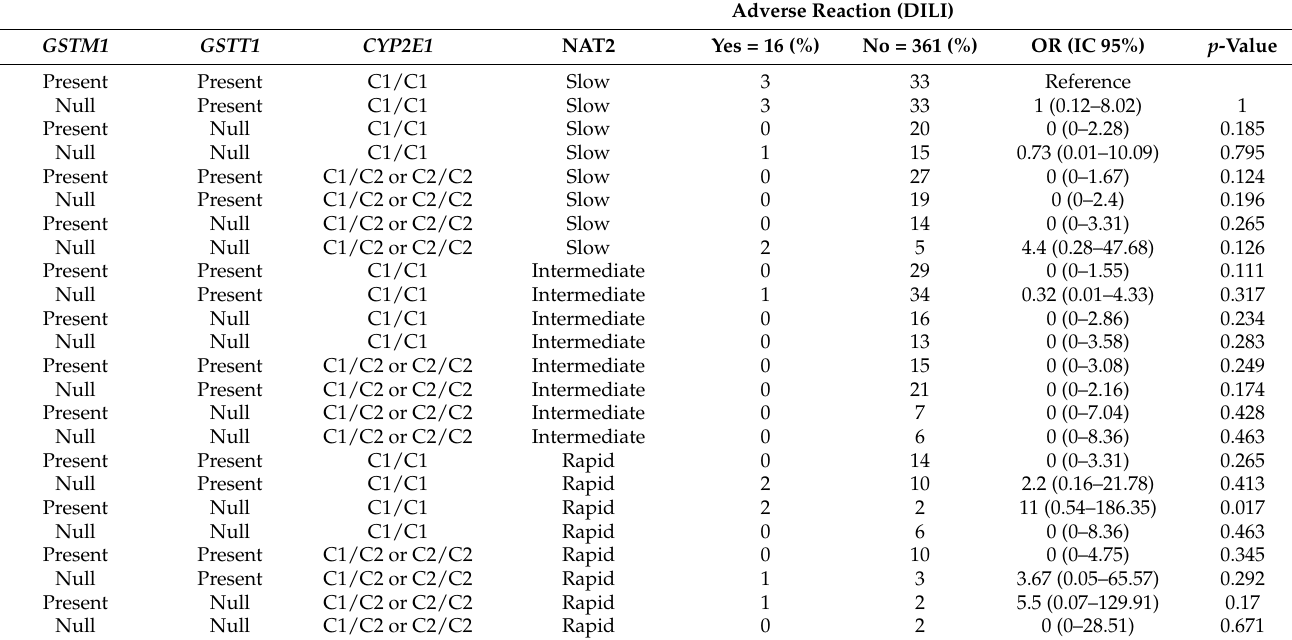
Table 3. Combined effects of NAT2, CYP2E1, and GST with the risk of DILI in the Peruvian population. Adverse Reaction